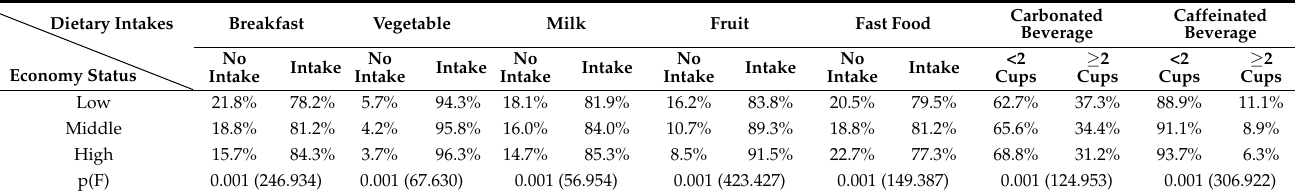
Table 5. Associations of dietary intake with the level of economic